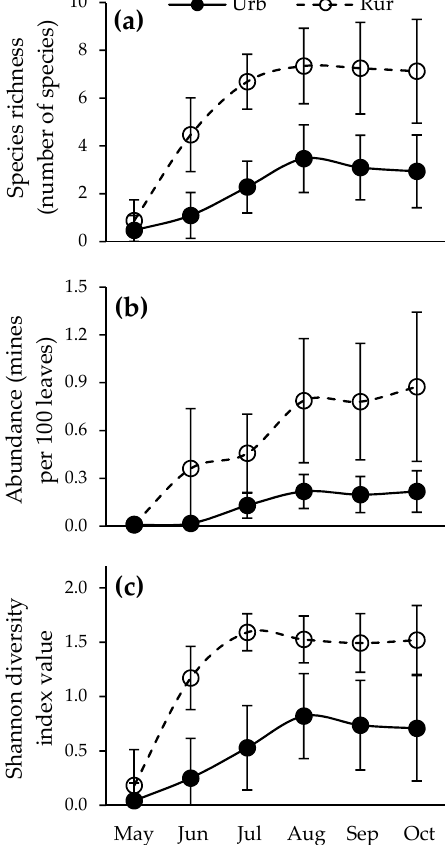
Figure 2. Seasonal dynamics of leaf miners: ( a ) species richness, ( b ) abundance, ( c ) diversity (mean ± s.d.) on trees in the urban and rural environments (Urb = Urban habitat; Rur = Rural habitat).